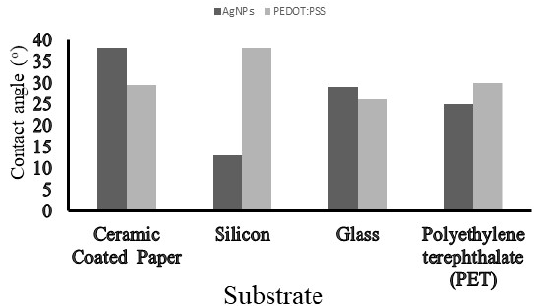
Figure 2. Contact angles measured via the sessile drop analysis method for the silver nanoparticles (AgNPs) and poly(3,4-ethylenedioxythiophene)-poly(styrenesulfonate) (PEDOT:PSS) inks and four potential substrates. The contact angle can be easily influenced by the nature of the substrate, mainly the surface.